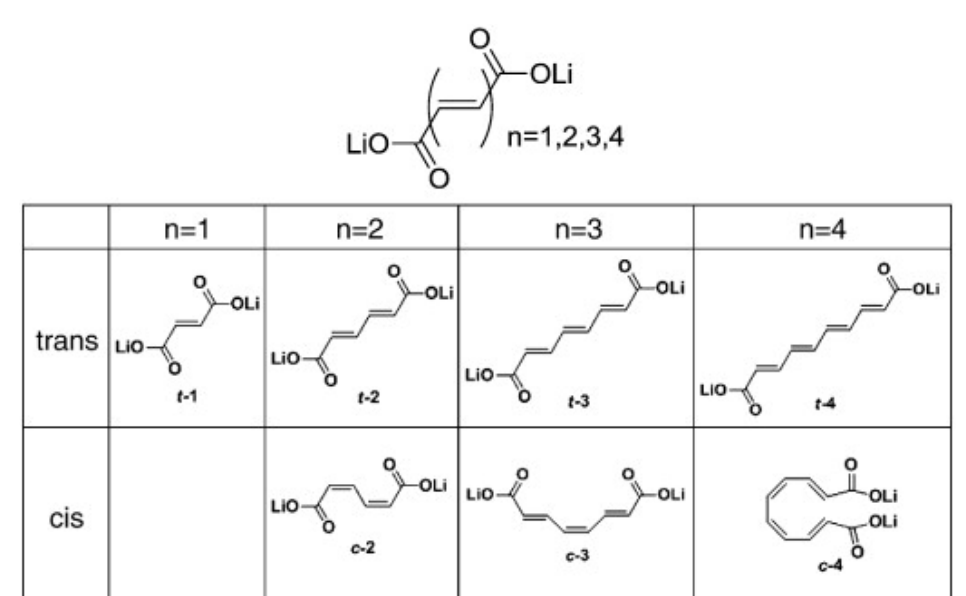
Figure 4. Chemical structures of the conjugated carboxylates with conjugation pathways of 2, 3, and 4 units. Reprinted from Ref. [72], Copyright 2010, with permission from Elsevier.